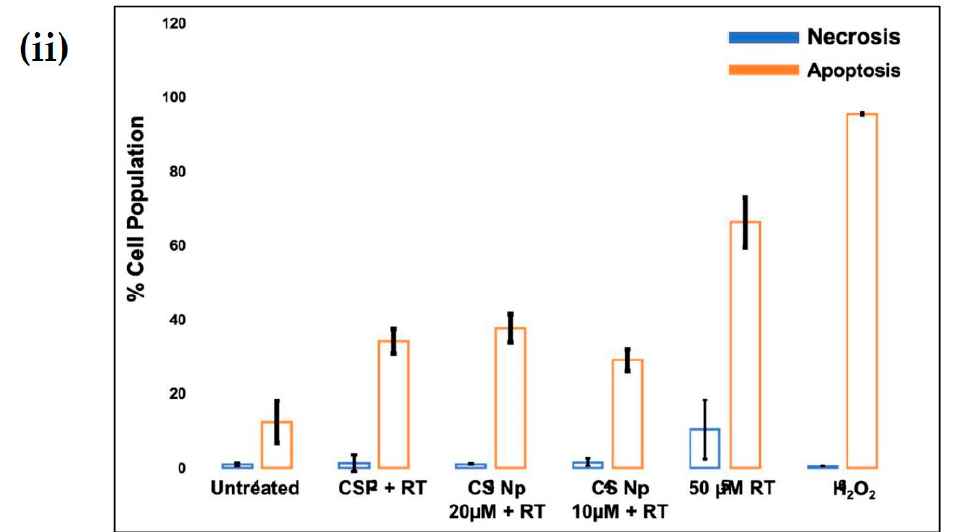
Figure 6. ( i ) Flow cytometry matrix plots used to measure apoptosis/necrotic distribution for ( A ) untreated, ( B ) 20 µ M Chitosan powder + RT, ( C ) CS Np 20 µ M, ( D ) CS Np+ RT, ( E ) 50 µ M RT, and (F)